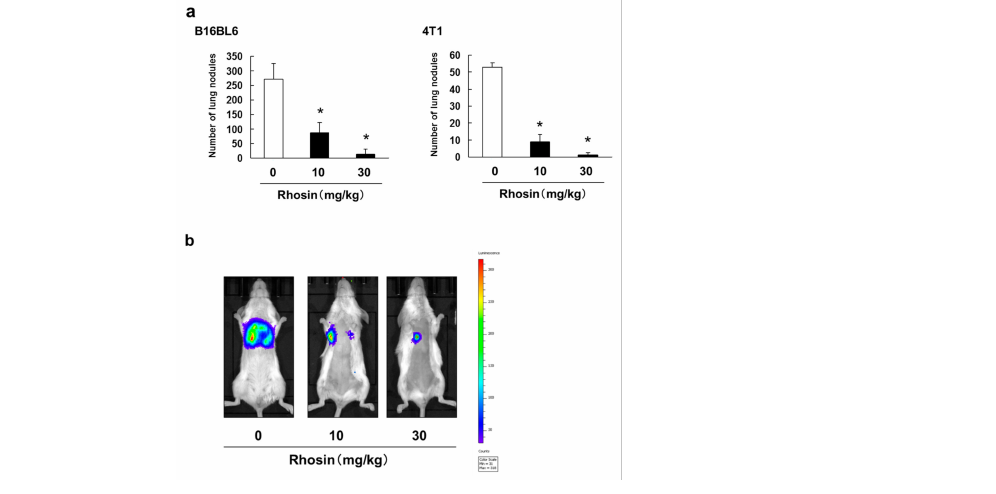
Figure 3. Inhibitory effect of intraperitoneal administration of rhosin on lung metastasis. ( a ) B16BL6 cells (1 × 10 5 cells in 0.2 mL) and 4T1 cells (1 × 10 5 cells in 0.2 mL) were injected into the tail vein of syngeneic C57BL/6J mice and Balb/c mice. Mice were treated daily from days 1 to 14 with 10 or 30 mg/kg rhosin. After 14 days, visible nodules that had metastasized to the lungs were counted. The results are expressed as the mean ± SD for 10 mice. * p < 0.01 vs. the controls (0.1% DMSO-treated) (ANOVA with Dunnett’s test); ( b ) Representative mice injected with 4T1-luc cells (1 × 10 5 cells in 0.2 mL). Mice were treated daily from days 1 to 14 with 10 or 30 mg/kg rhosin. On day 14, tumor cells in mice were detected by IVIS Lumina XRMS Series III Imaging System.